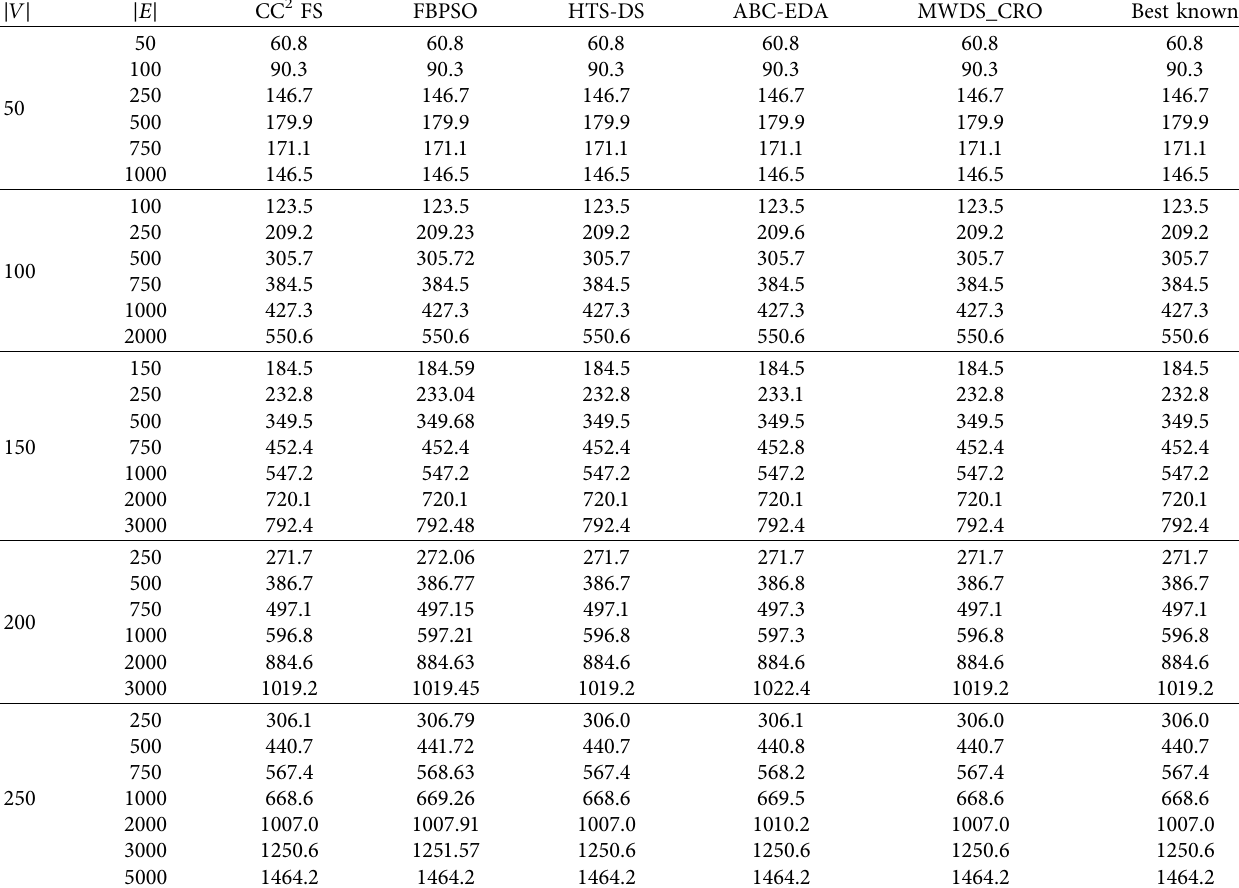
Table 5: Type TII class SMPI-comparison of MWDS_CRO for various parameters with recent state-of-the-art algorithms.